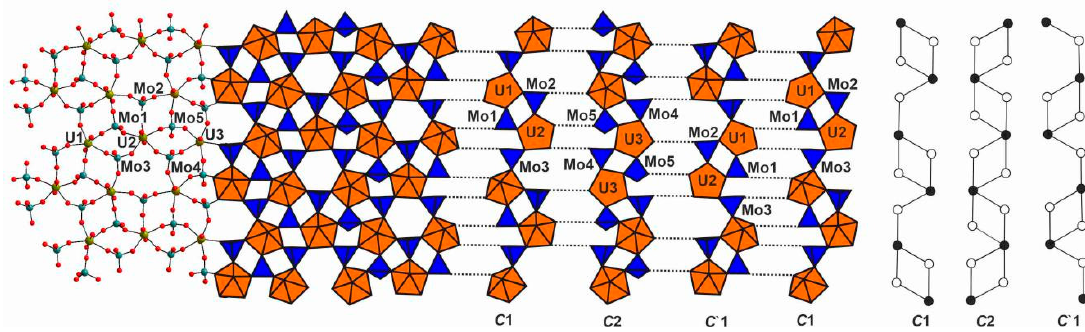
Figure 4. The topology of [(UO 2 ) 3 (MoO 4 ) 5 ] 4 − layer in 1 . Three topologies of UO 2 : T O 4 = 3:5 layers [14] are known to date. Two of them are represented in Figure 5. In all cases, the layers can be described as alternations of chains.